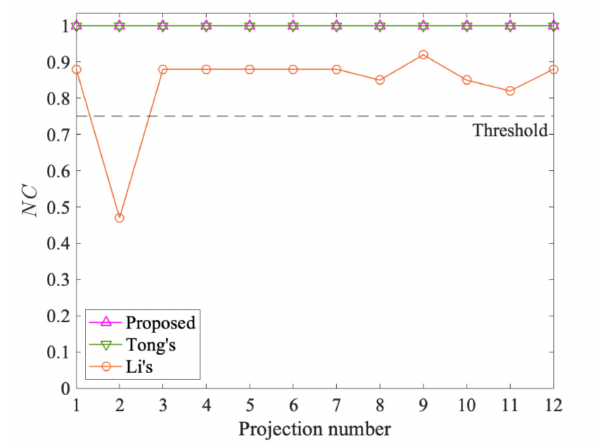
Figure 10. The results of Division.